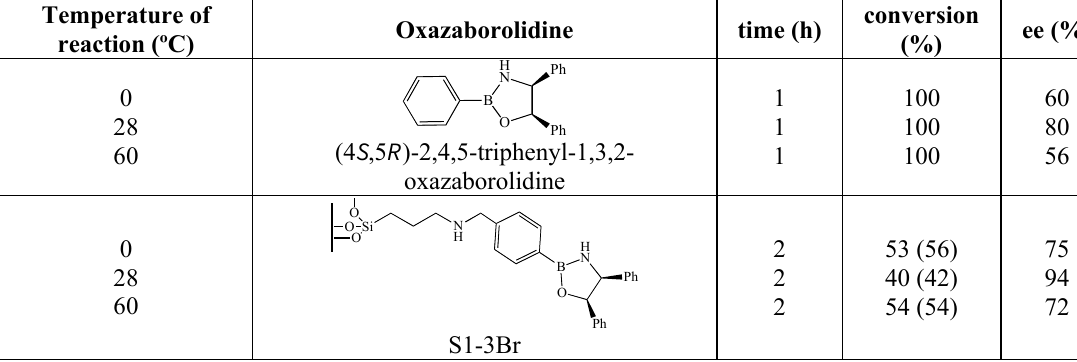
Table 6. Influence of the temperature on the